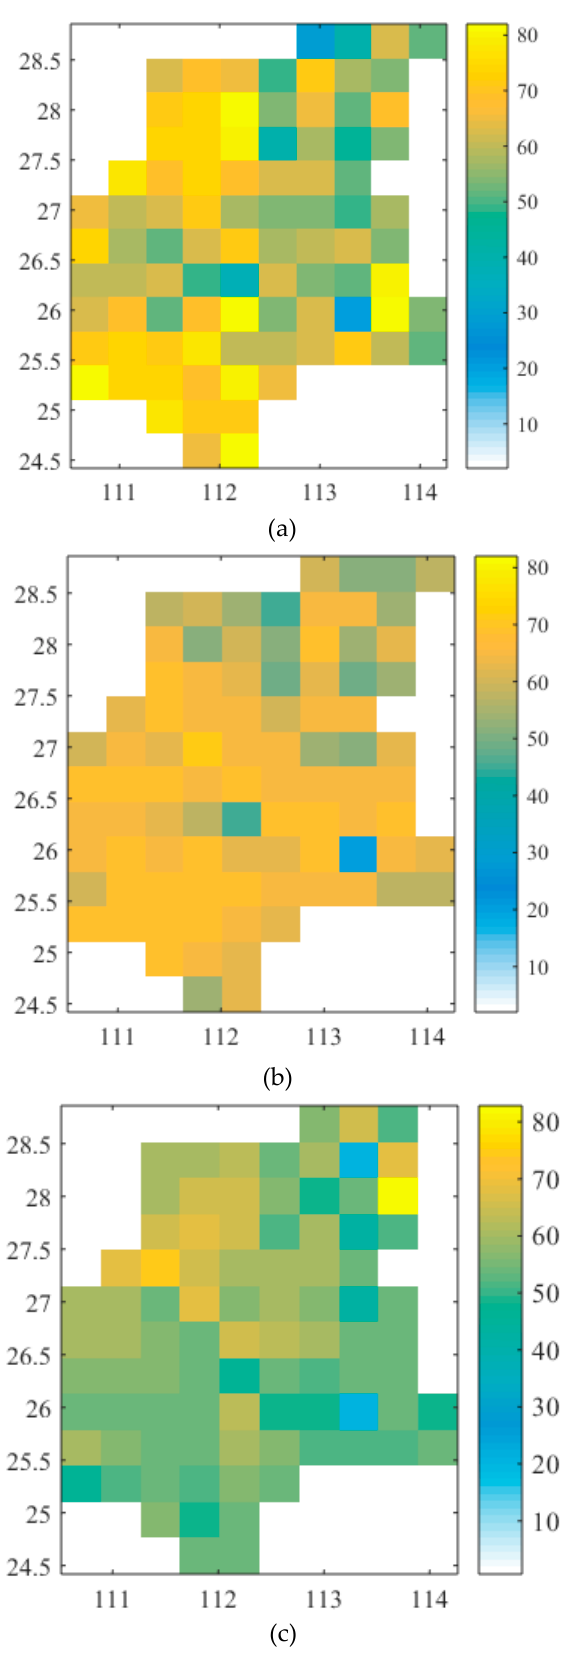
Figure 7. Spatial distribution of percentage of drought weeks (PDWs) (%) in 2015 ( a ), 2016 ( b ), and 2017( c ), respectively.